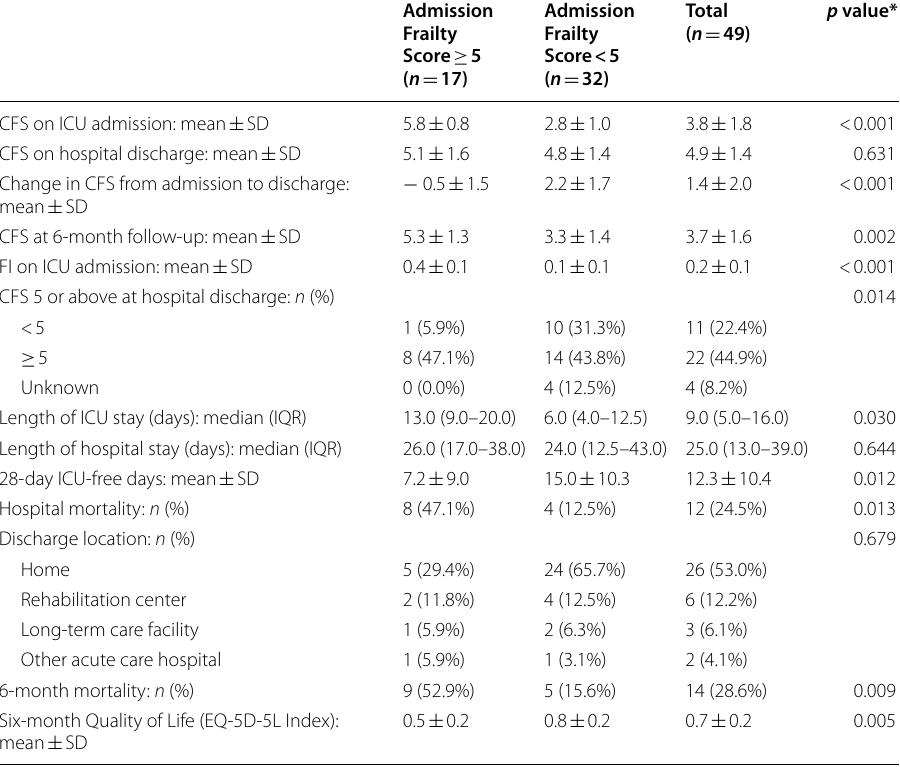
Table 5 Outcomes by admission clinical frailty